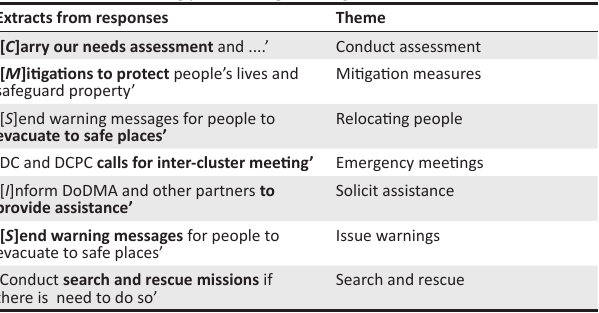
TABLE 3: Activities taking place during flooding.